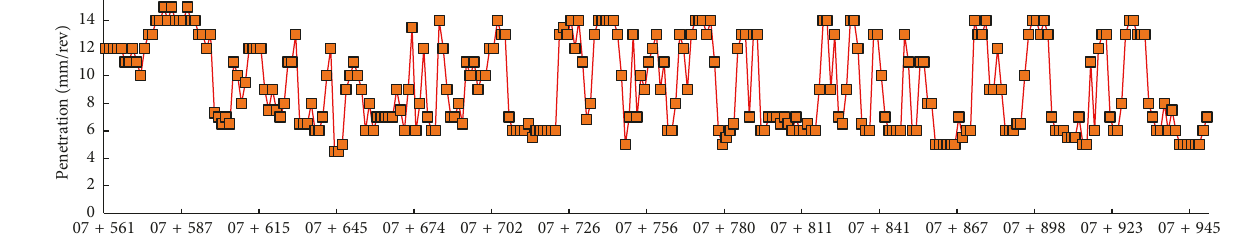
Figure 13: The recorded penetration along the Neelum–Jhelum TBM diversion